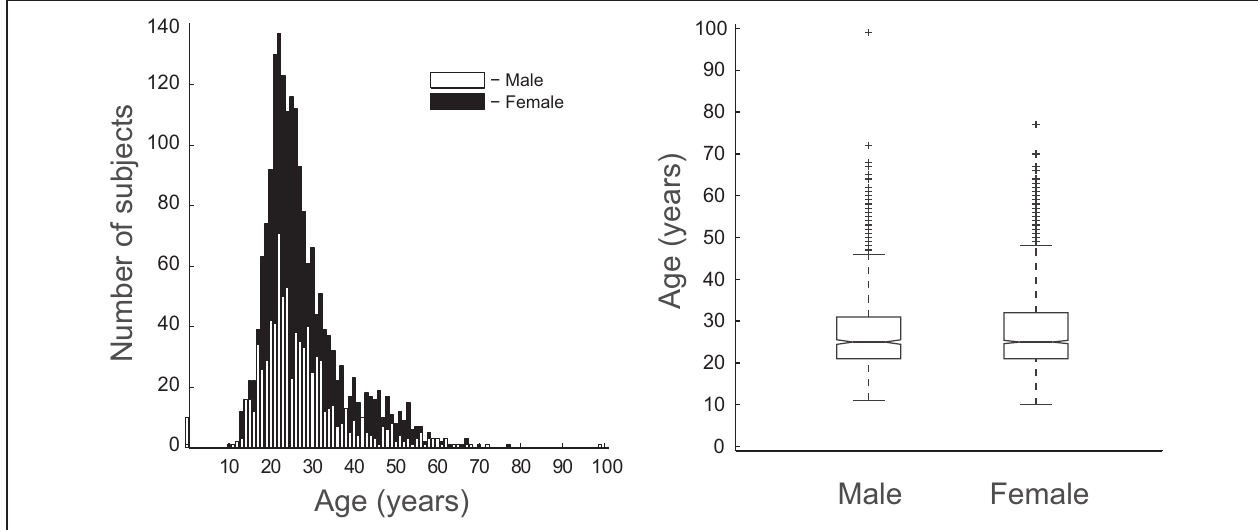
FIGURE 1 | Epidemiological characteristics of the population sample. Age distribution (left; white bars = male, black bars = female) and boxplot of ages within genders (right). Outliers indicated by